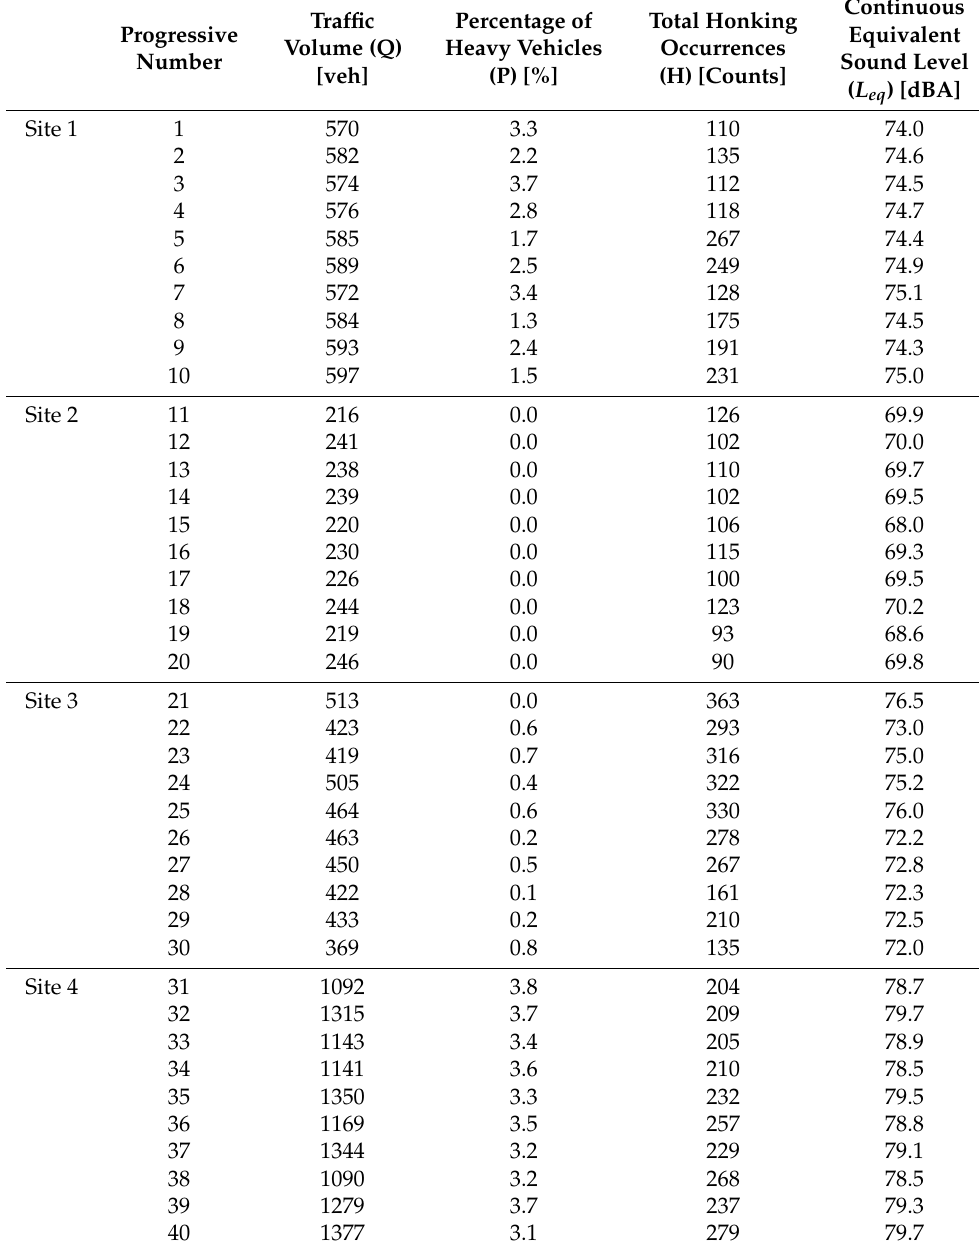
Table A1. Full dataset containing traffic volumes (Q), percentage of heavy vehicles (P), total honking occurrences in 15 min (H) and continuous equivalent sound level ( L eq ) for all the measurements, in all the